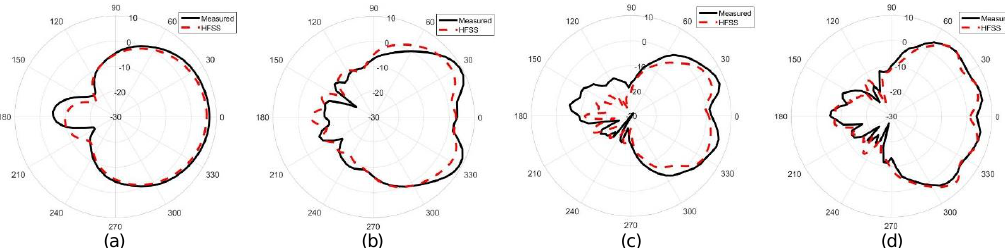
Figure 7. Sample plots comparing simulated and measured total gain patterns at: ( a ) 0.5, ( b ) 2, ( c ) 4 and ( d ) 5 GHz. Patterns are plotted in the yz